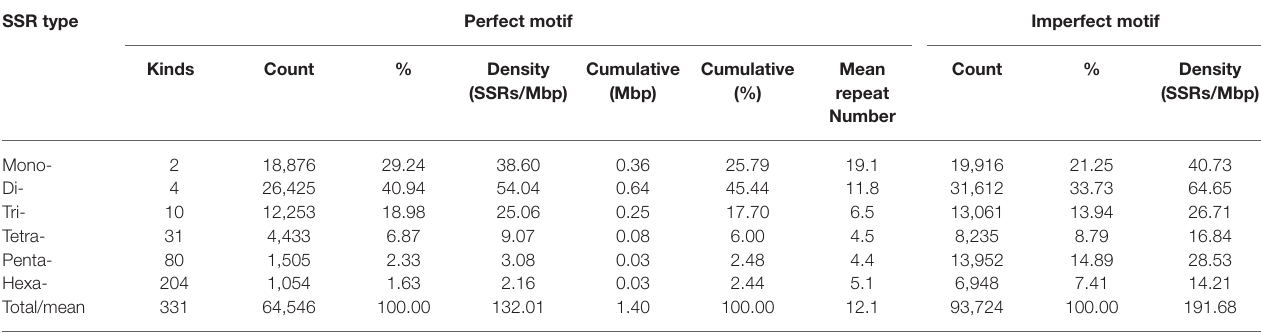
TABLE 2 | Variation in the repeat length among genomic cabbage perfect and imperfect